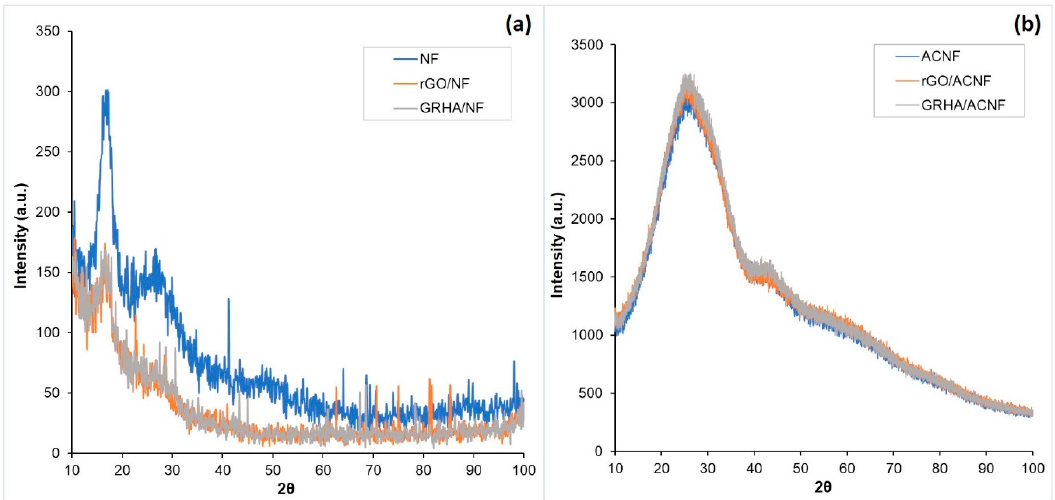
Figure 3. XRD spectra of pristine and composite nanofibers ( a ) prior to activation and ( b ) after activation. ACNF: activated carbon nanofibers, rGO: ACNF: activated carbon nanofibers, GRHA: graphene-derived rice husk ashes.